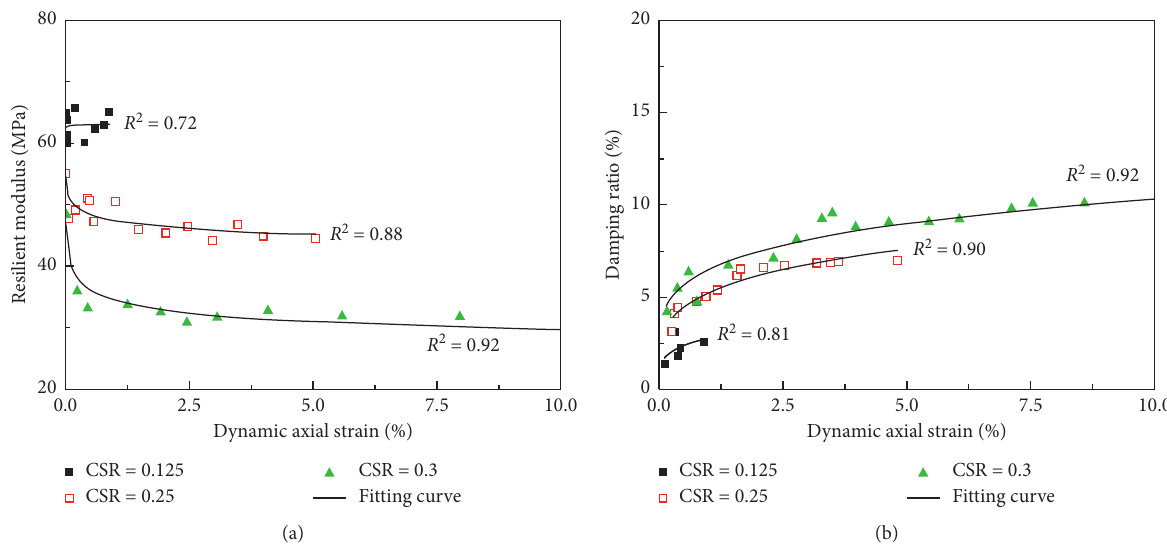
Figure 4: Variations of dynamic parameters with dynamic axial strain at different CSR: (a) M